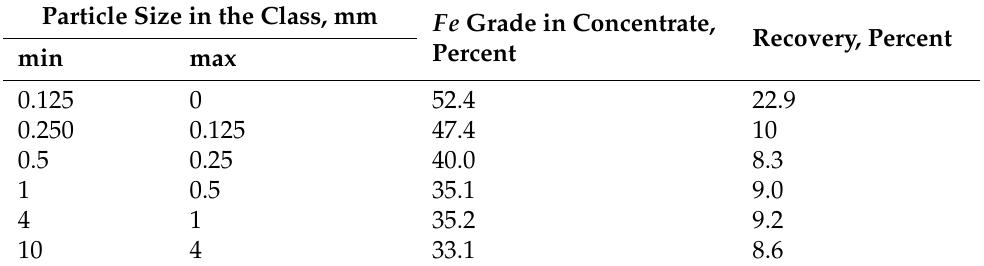
Table 7. Magnetic separation of various size particles ground to − 0.125 mm size